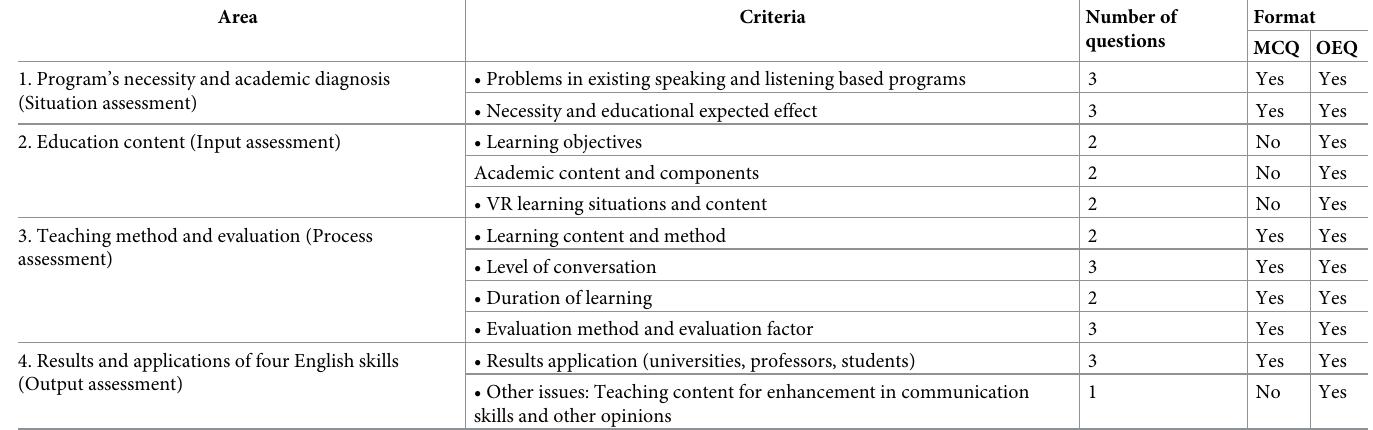
Table 2. First Delphi survey with the application of CIPP model (2019.11.04 ~